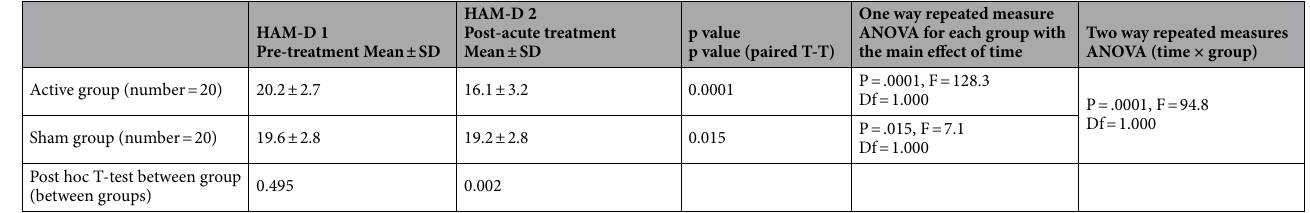
Table 6. Effect of HF-rTMS on the Hamilton Anxiety Rating Scale pre-treatment (HAMA1), and post-acute treatment (HAMA 2).